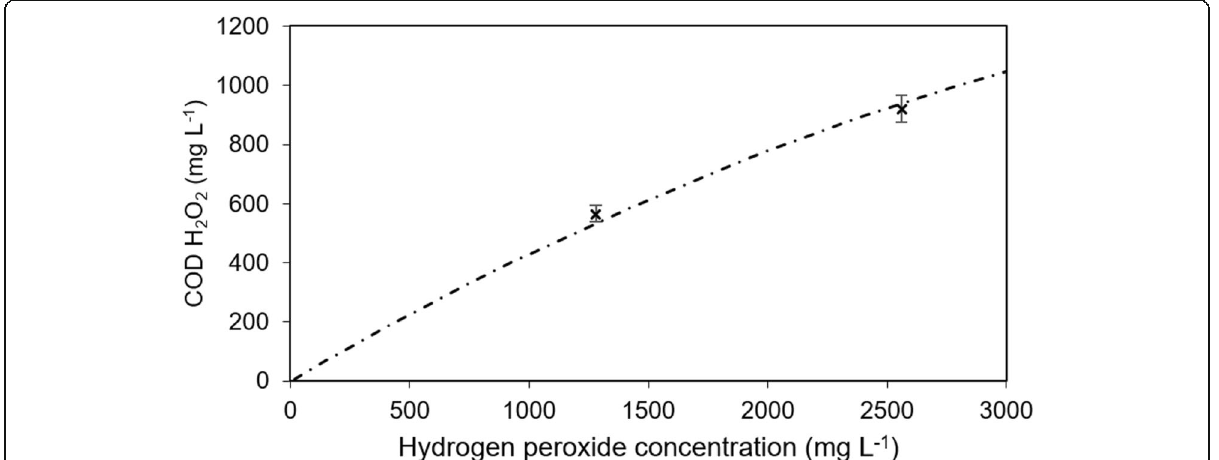
Fig. 8 Experimental (symbols) and modelled data (according to Eq. (9), dotted line) for COD test as a function of hydrogen peroxide